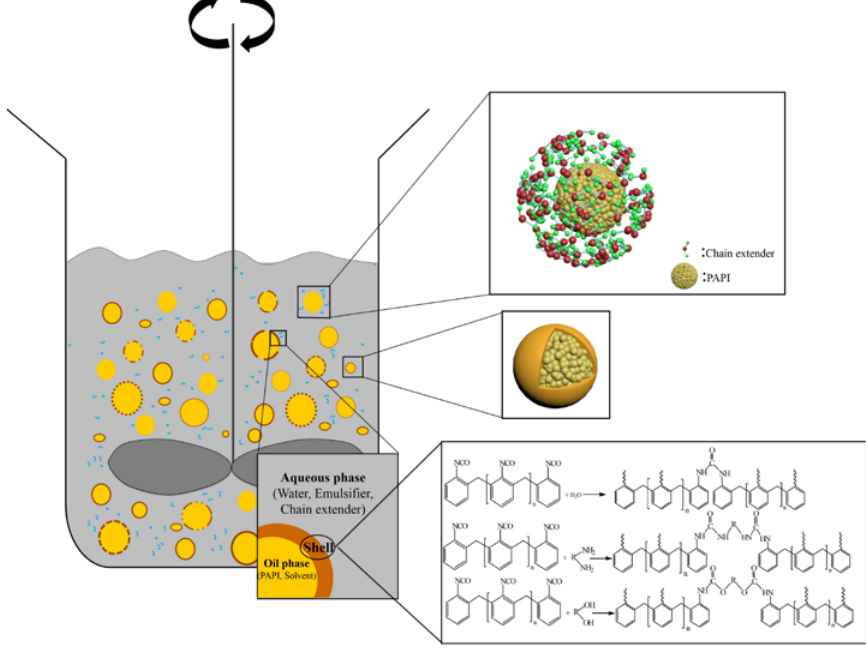
Figure 1. Schematic diagram of capsule shell formation under mechanical agitation and the related chemical reaction.